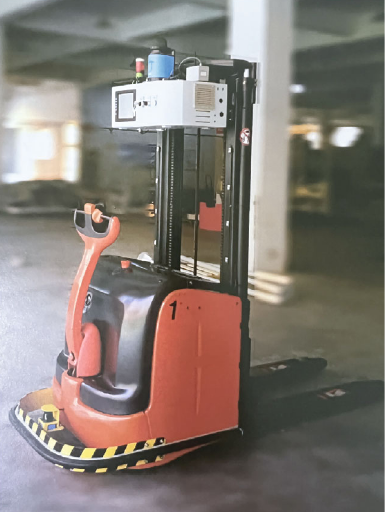
Figure 6: The stack-type